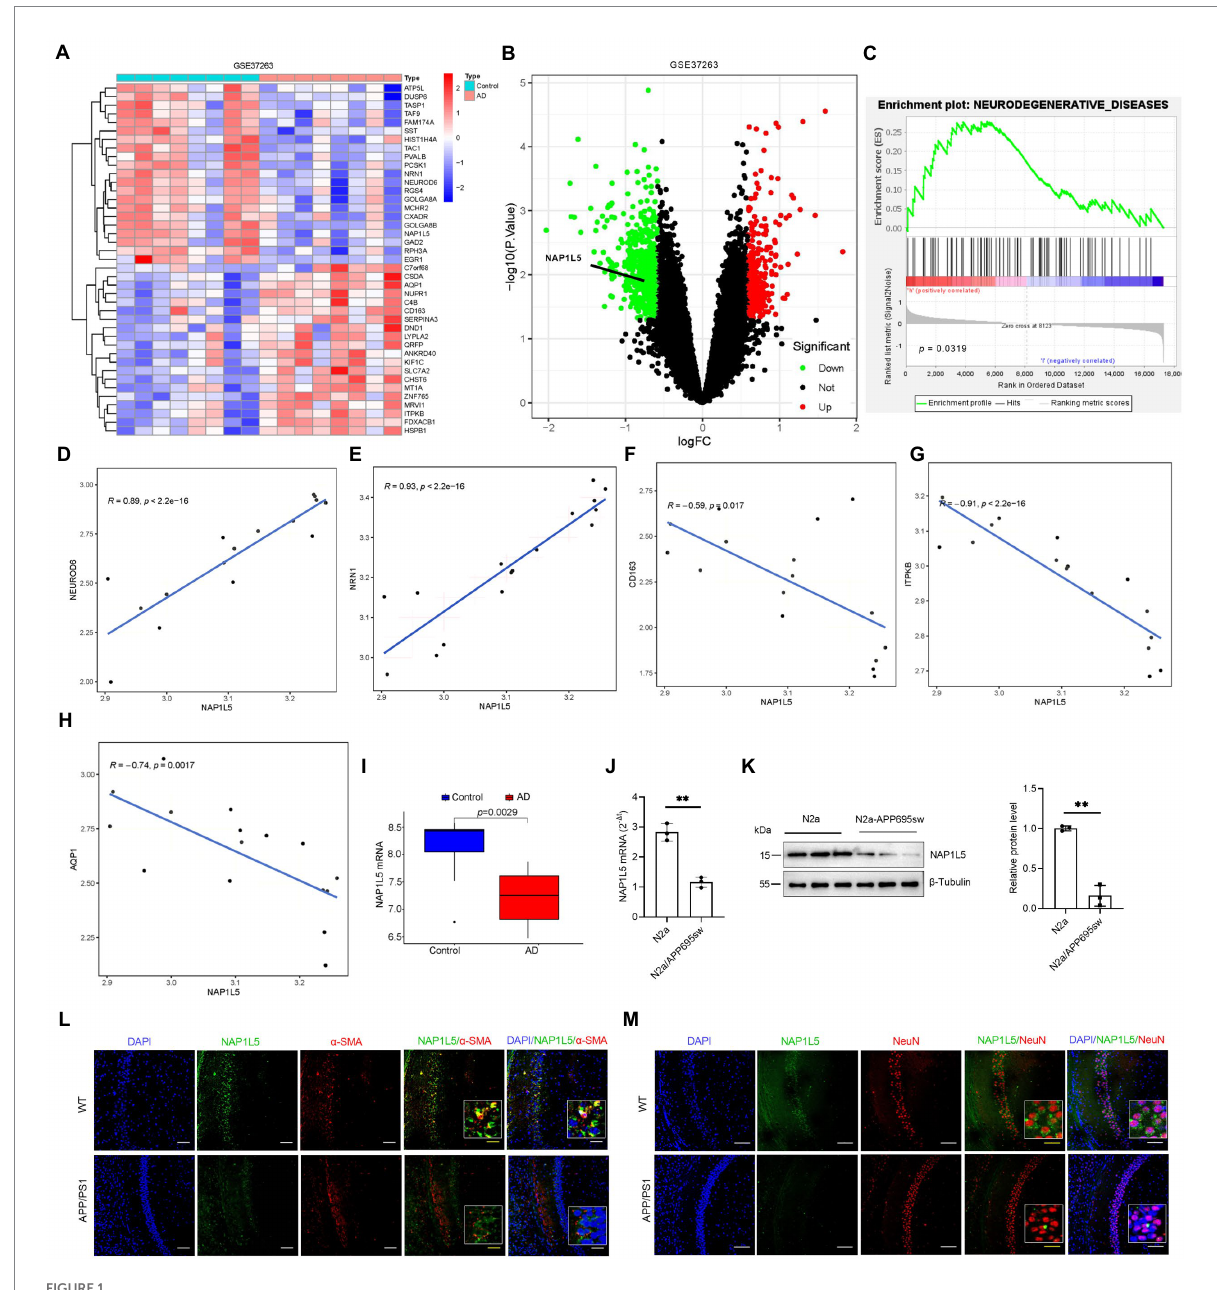
FIGURE 1 NAP1L5 was downregulated in Alzheimer’s disease (AD) patients and the AD cell model. (A) A heatmap showing the differentially expressed genes in the brain tissues of AD patients and controls according to the GEO (GSE37263) dataset. (B) Volcano plots showed that NAP1L5 was significantly differentially expressed. (C) GSEA analysis showed that NAP1L5 expression was significantly correlated with neurodegenerative diseases in the GSE37263 datasets. (D–H) The NAP1L5 expression was significantly correlated with NEUROD6, NRN1, CD163, ITPKB, and AQP1. (I) NAP1L5 mRNA level was analyzed in the brain tissues of AD patients and controls from GSE37263. NAP1L5 mRNA (J) and protein (K) levels were detected in the cell model of AD. (L,M) Relationship of NAP1L5 with alpha-smooth muscle actin ( α -SMA) fraction and neuron. (L) Representative immunofluorescence images of hippocampus CA1 showing NAP1L5 (green) merged with α -SMA (red). Scale bars, 100 μ m. (M) Representative immunofluorescence images of hippocampus CA1 showing NAP1L5 (green) merged with neuron (NeuN, red). Scale bars, 100 μ m. Data are present as means ± SD, n = 3. ∗ p < 0.05. Student’s